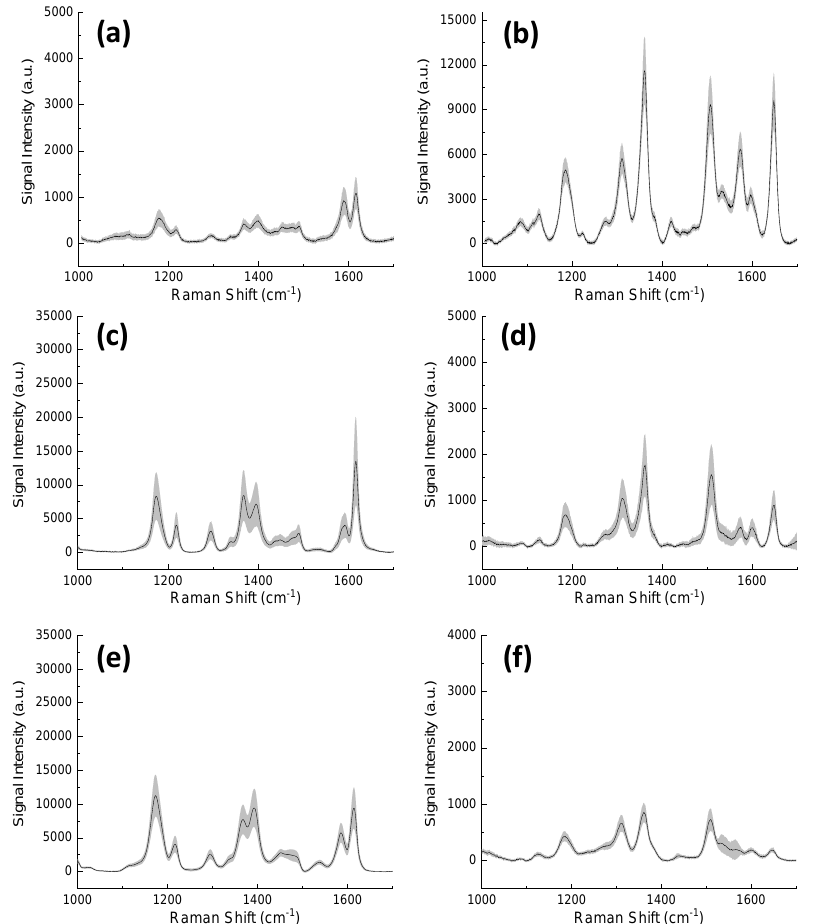
Figure 8. Raman analysis with Au / Si Π structures of 2 µ M Malachite Green ( a - c - e ) and 2 µ M Rhodamine 6G ( b - d - f ) using three different excitation lasers 533 nm ( a , b ), 633 nm ( c , d ), and 785 nm ( e , f ).